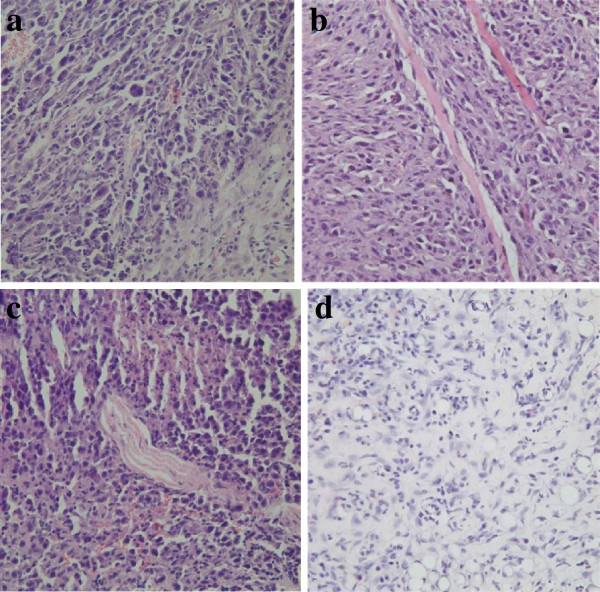
Tumor tissue in HEpathologyat 8 hours after treatment (HE×40). a: Control, b: 131I, c: His-IN, d: 131I-His-IN.